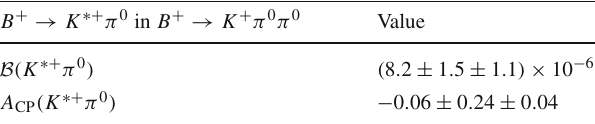
Table 6 Central values of the observables from the BaBar analysis of B + → K ∗+ ( 892 )π 0 quasi-two-body contribution to the B + → K + π 0 π